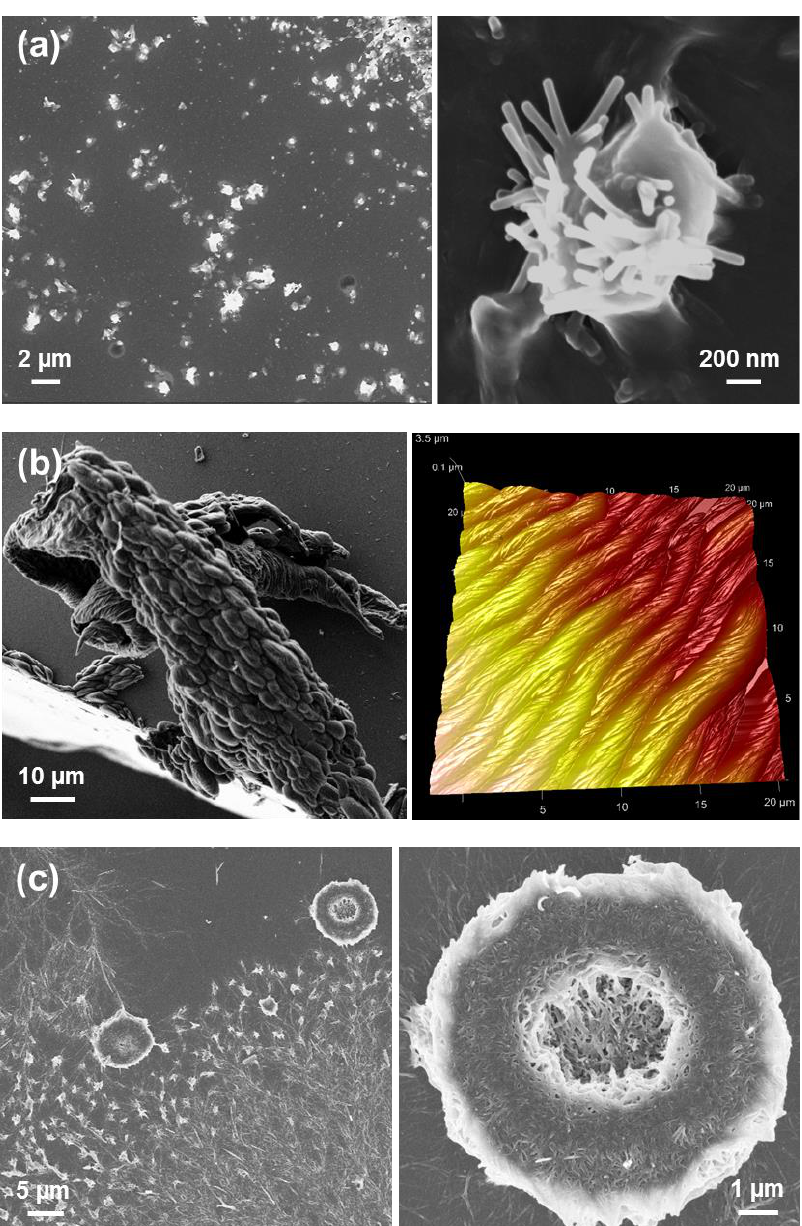
Figure 13. ( a – c ) SEM and (b) AFM (20 × 20 µm 2 ) images of the structures obtained from Fmoc-FF-OFm solutions in ( a ) 1:99 HFIP:water (0.05 mg/mL), ( b ) 1:9 HFIP:water (0.5 mg/mL), and ( c ) 4:1 HFIP:water (4 mg/mL) mixtures.